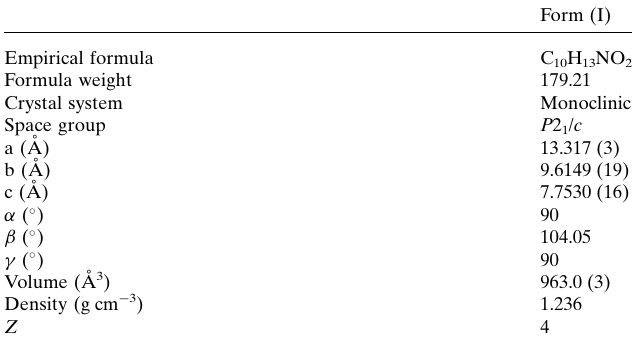
Table 2 Single crystal data of form I.